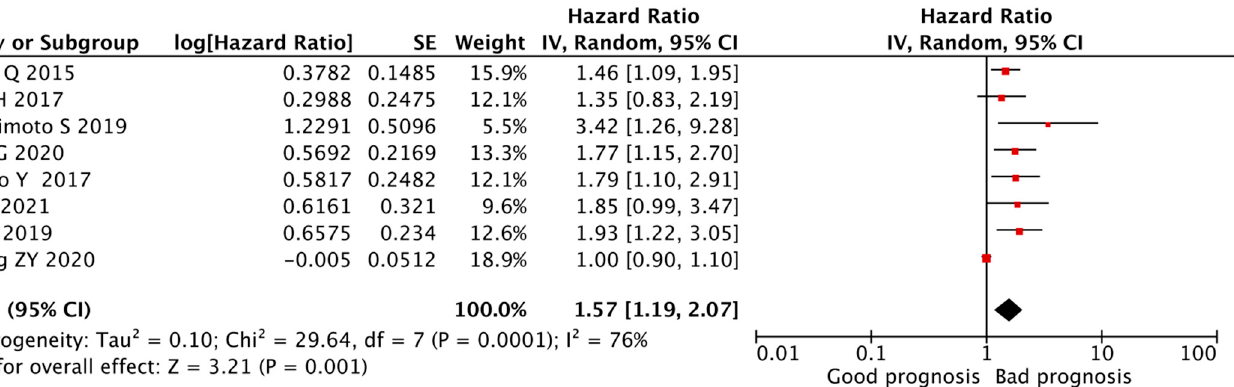
Figure 2. Forest plot of the correlation between PLR and OS in CCA patients. A random-effects model was used to estimate the relationship between PLR and OS. OS, overall survival; PLR, plate- let-to-lymphocyte ratio.